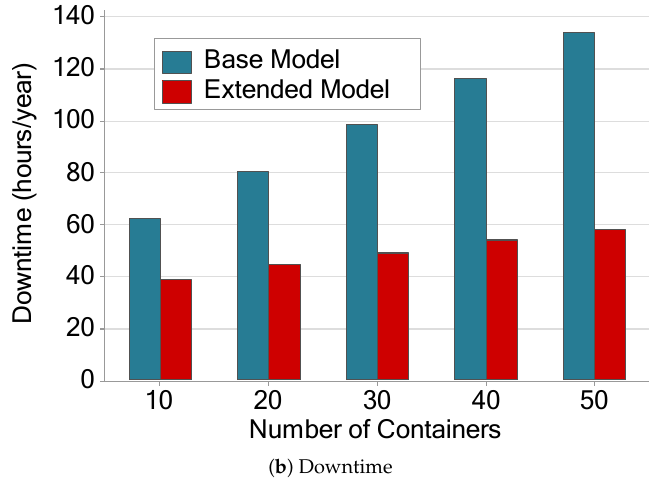
Figure 16. Availability and downtime of the two architectures varying the number of